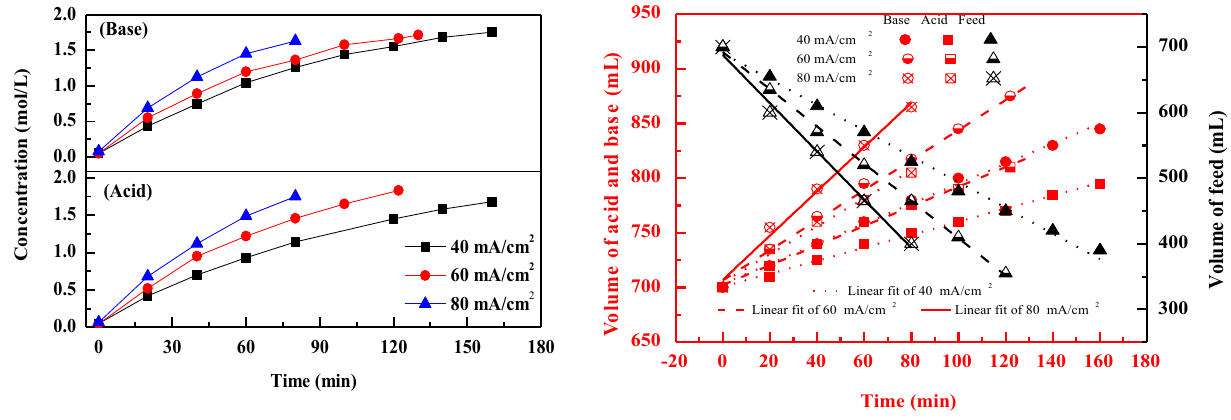
Fig. 9 Variation of HCl and LiOH concentration (left) and solution volume in feed, acid and base compartments under different current den- sities